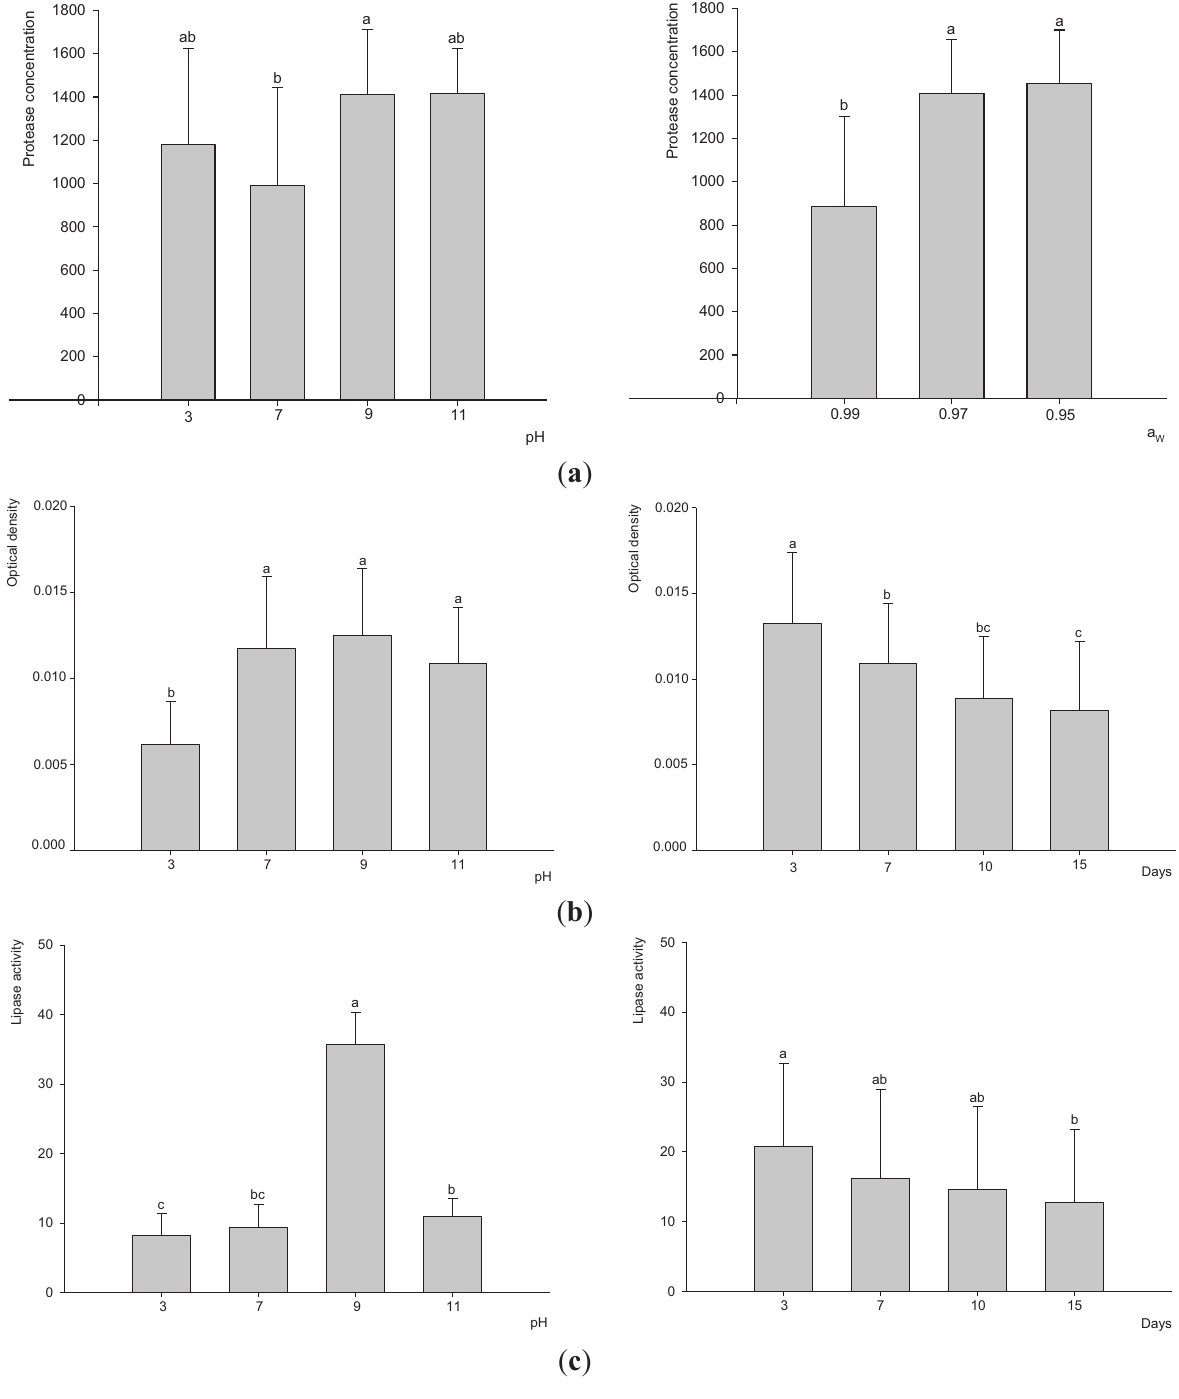
Figure 3. Production of proteases ( a ), amylases ( b ) and lipases ( c ) by both strains of P. lilacinum JQ926223 and JQ926212. Bars represent means and standard errors for each condition of Aw, pH and incubation time (days). Data with different letters for each Aw, pH or incubation time are significantly different based on LSD Fisher test ( P <